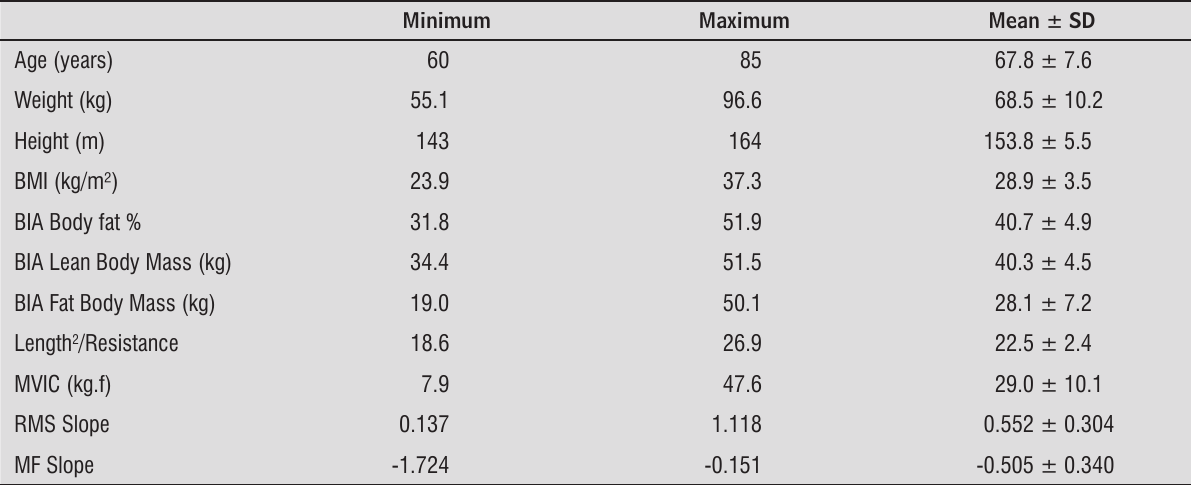
Table 1 - Sample characteristics and results of the tests of BIA, Maximum Strength and Resistance to Fatigue Minimum